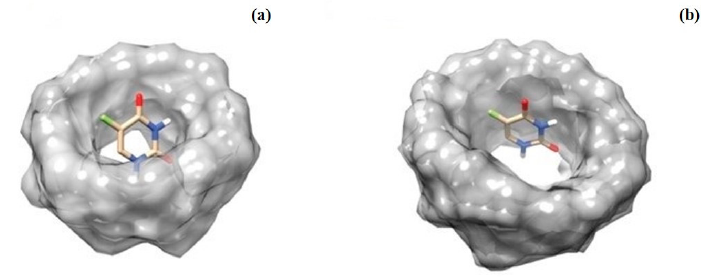
Figure 9. Molecular docking models of the 5-FU in complex with the α -CD ( a ); and β -CD ( b ).